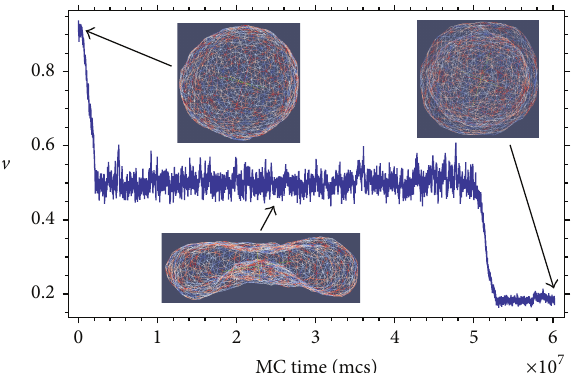
Figure 4: Monte Carlo evolution of the vesicle with pressure difference Δ𝑝 = −0.071 from an initial quasispherical state towards an equilibrium stomatocyte state. The reduced volume of the vesicle is shown as a function of the Monte Carlo time (measured in mcs). The average reduced volume in the equilibrium stomatocyte state is ⟨ V ⟩ = 0.185 ± 0.007 , while in the metastable oblate discocyte state it is ⟨ V ⟩ = 0.50 ± 0.02 . The snapshots of the initial quasispherical, discocyte, and stomatocyte states are shown for the appropriate values of the reduced